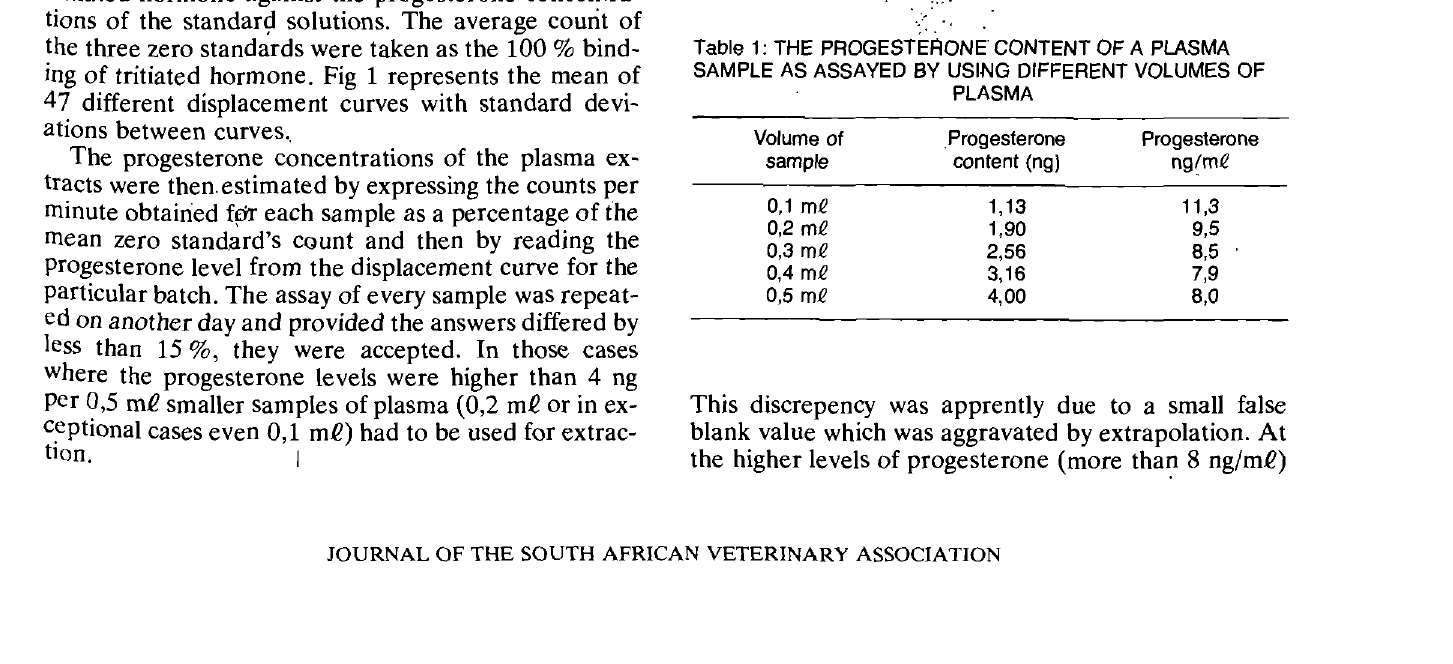
Table 1: THE PROGESTERONE CONTENT OF A PLASMA SAMPLE AS ASSAYED BY USING DIFFERENT VOLUMES OF PLASMA Volume